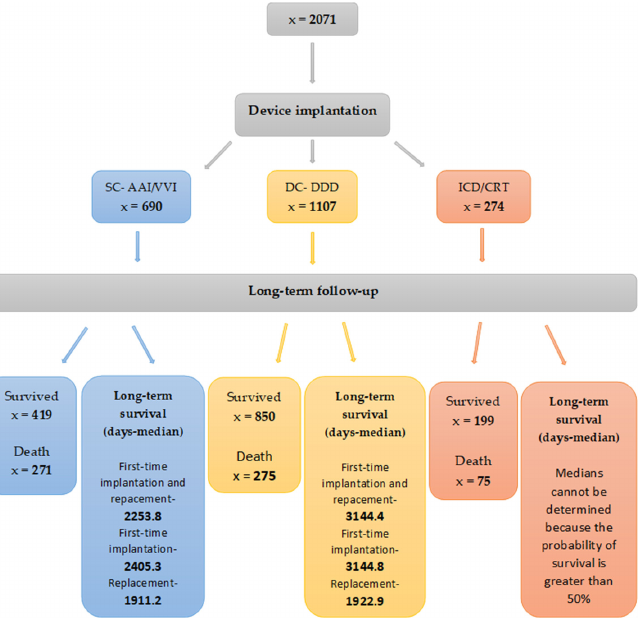
Figure 1. A flowchart of the study with the long-term survival of patients depending on the type of implanted